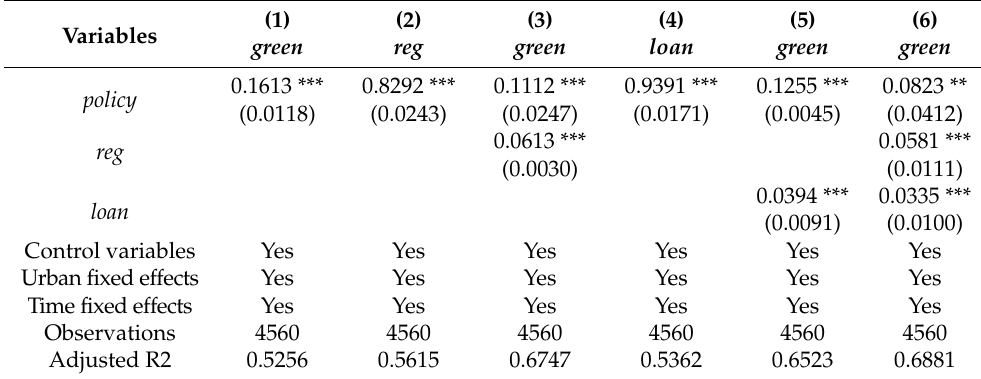
Table 8. Results of intermediary mechanism